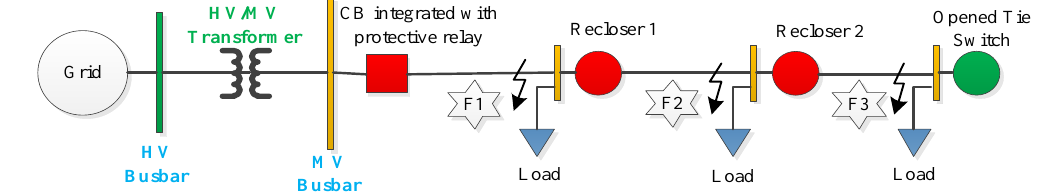
Figure 5. Single-line diagram of a typical feeder of a distribution network.